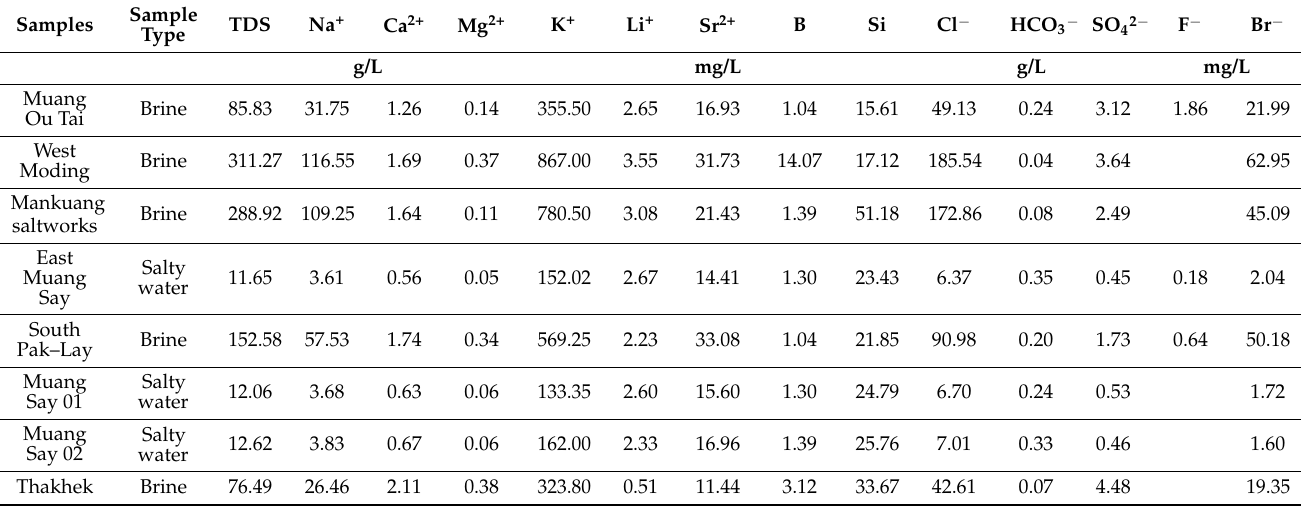
Table 1. Hydrochemical composition of salty groundwater and brines from springs in northern and central Laos.